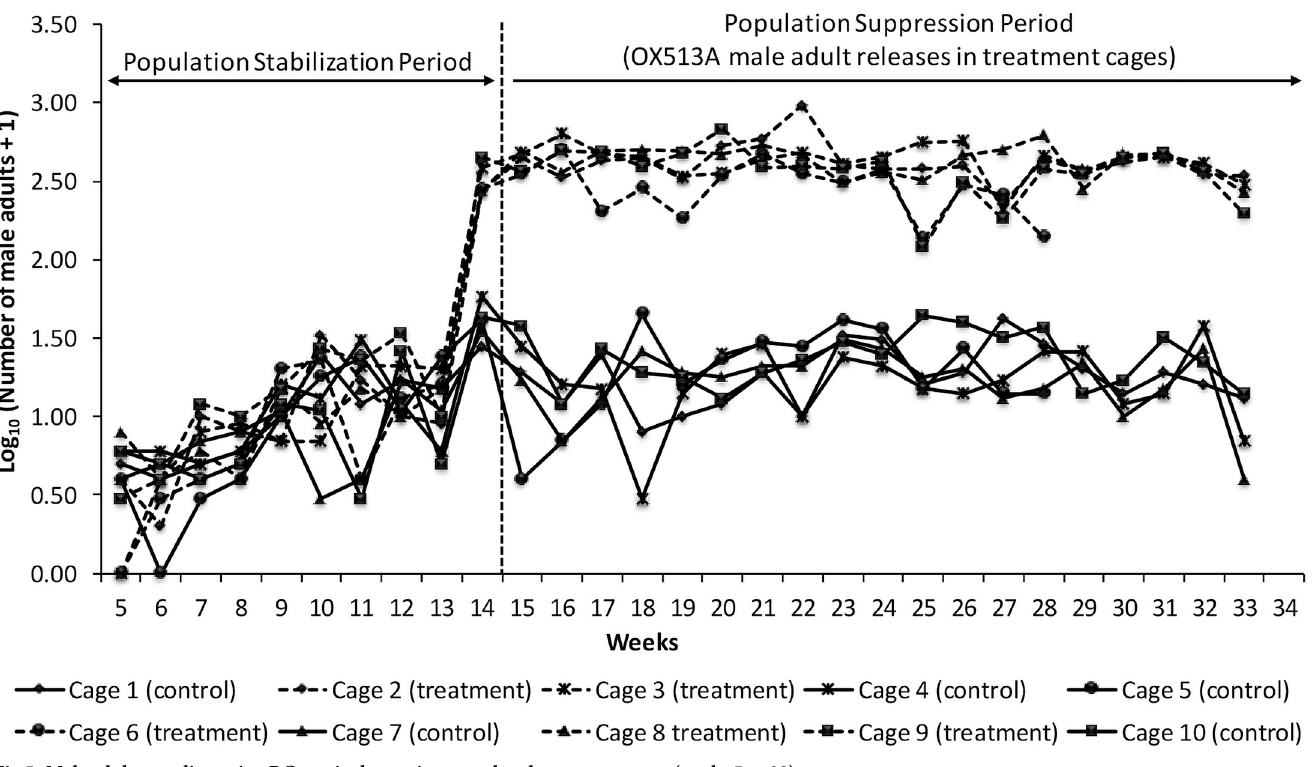
Fig 5. Male adult sampling using BG sentinel traps in control and treatment cages (weeks 5 to 33).